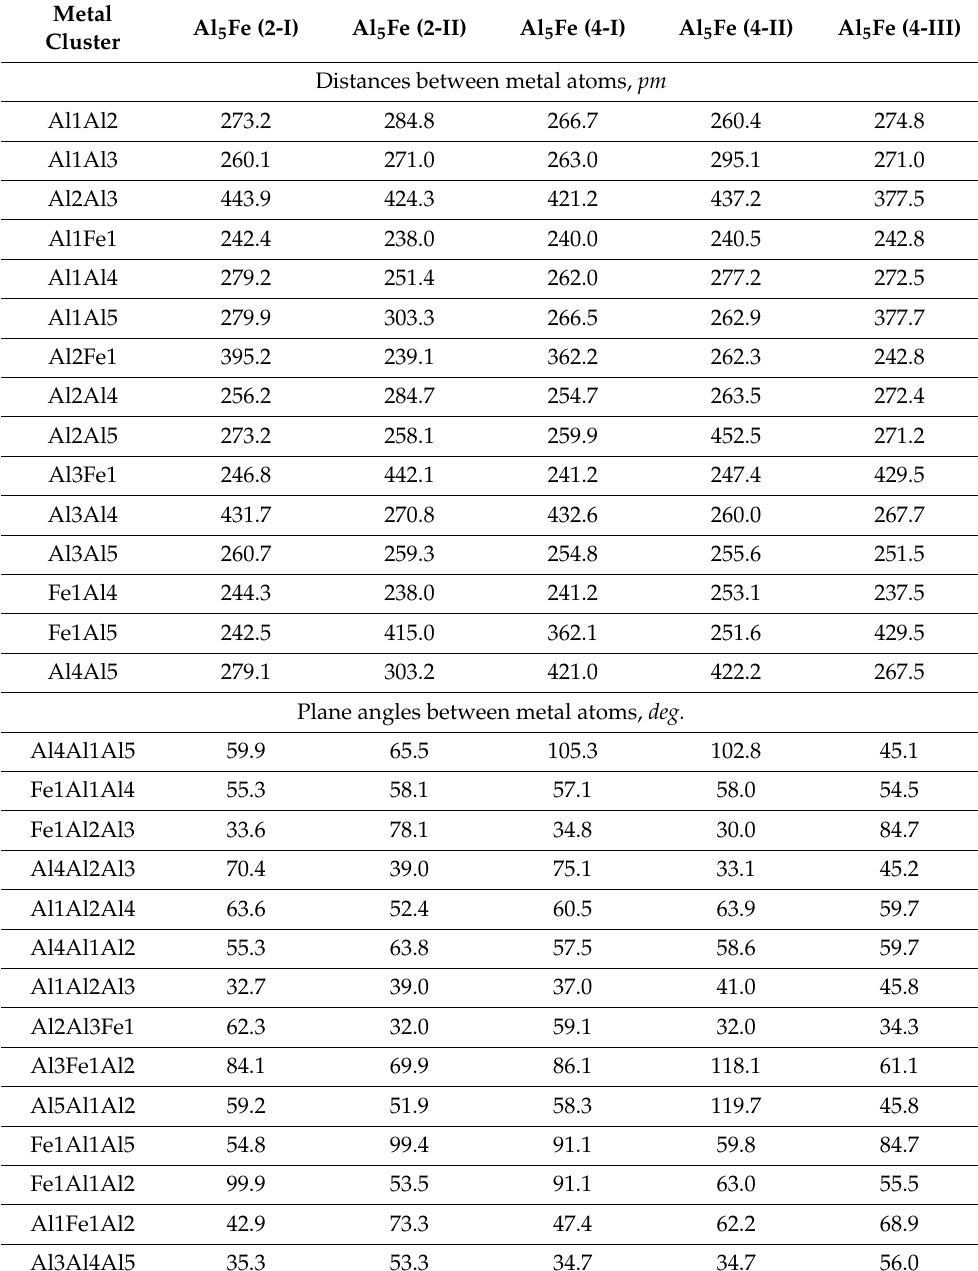
Table 2. Key structural parameters of the most stable Al 5 Fe metal